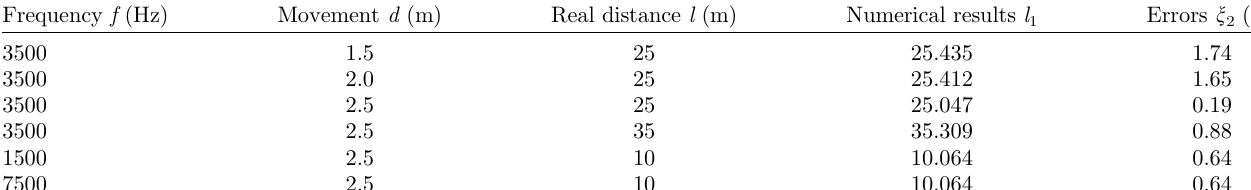
Table 4. Underwater sound localization when movement d is 1.5 – 2.5 m.